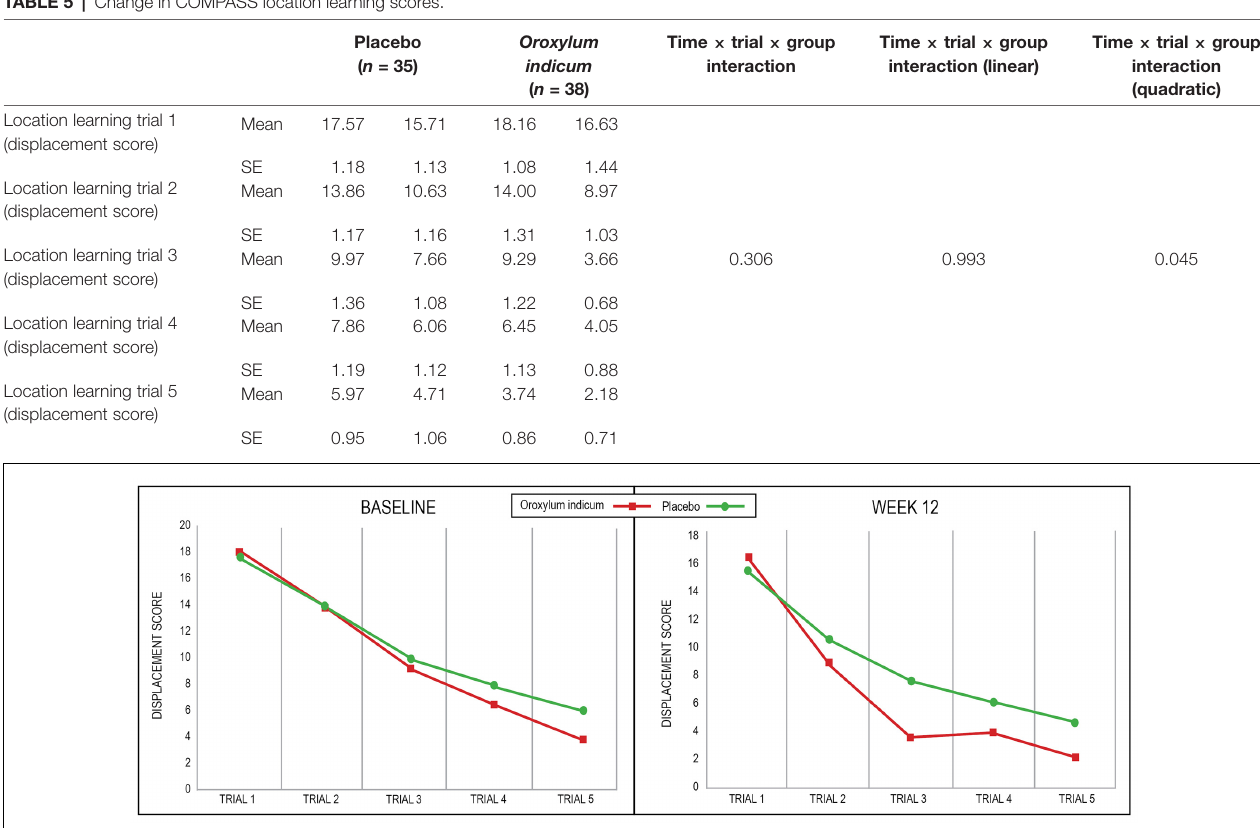
TABLE 5 | Change in COMPASS location learning scores.